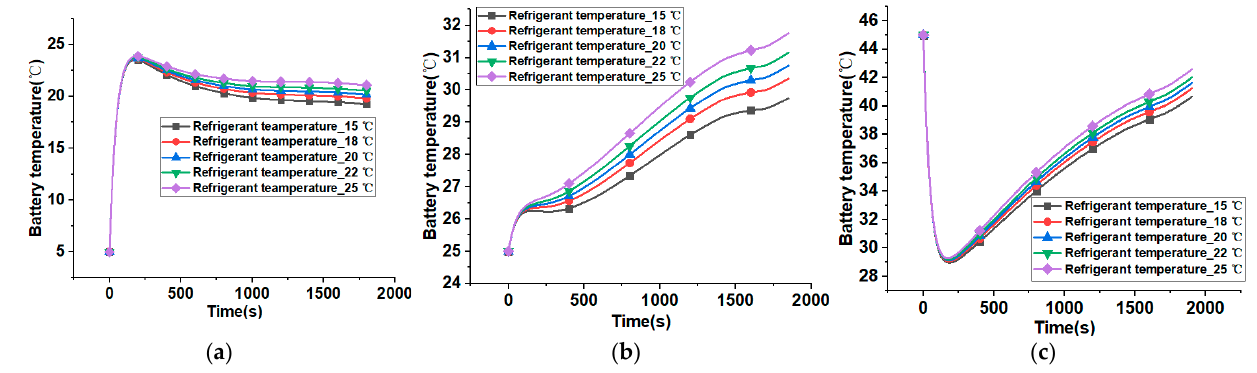
Figure 10. ( a ) Environment temperature_5 °C_Refrigerant temperature impact; ( b ) Environment temperature_25 °C_Refrigerant temperature impact; ( c ) Environment temperature_45 °C_Refrigerant temperature impact.